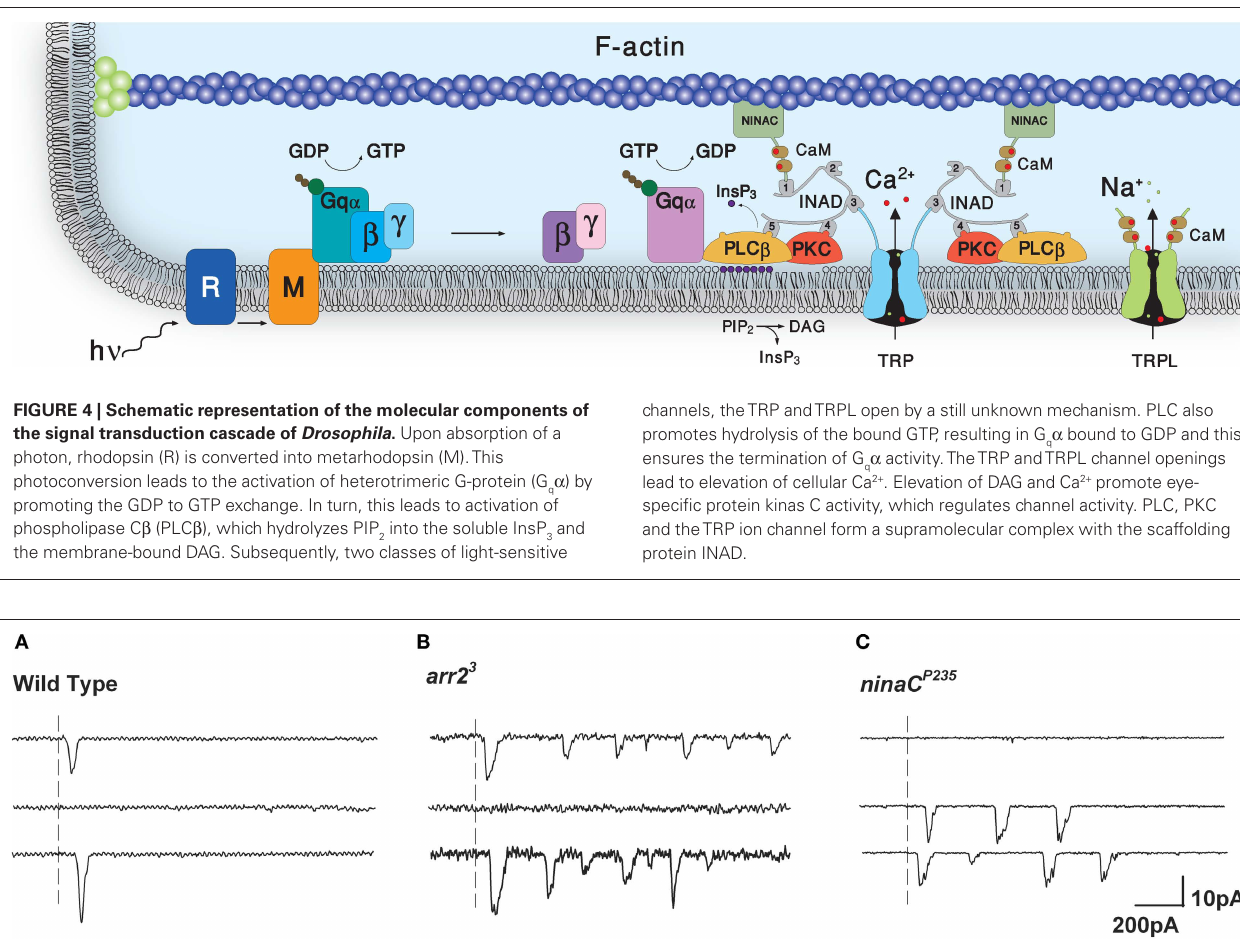
(middle trace). In contrary, a single fl ash in arr2 3 and ninaC P235 mutant fl ies elicits a train of bumps. (A–C) Lower panels: Whole-cell voltage clamp recordings of normalized macroscopic responses of WT and the corresponding mutants in response to 500-ms light pulses. A slow termination of macroscopic response is observed in arr2 3 and ninaC P235 mutant fl ies relative to WT.